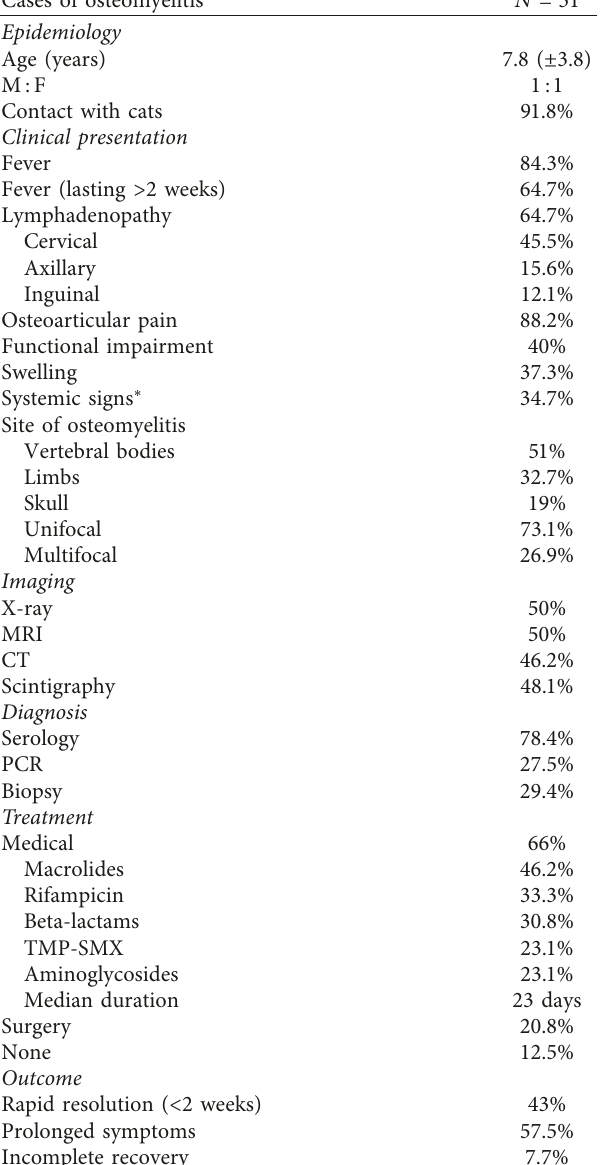
Table 1: Pediatric cases of osteomyelitis related to Bartonella henselae